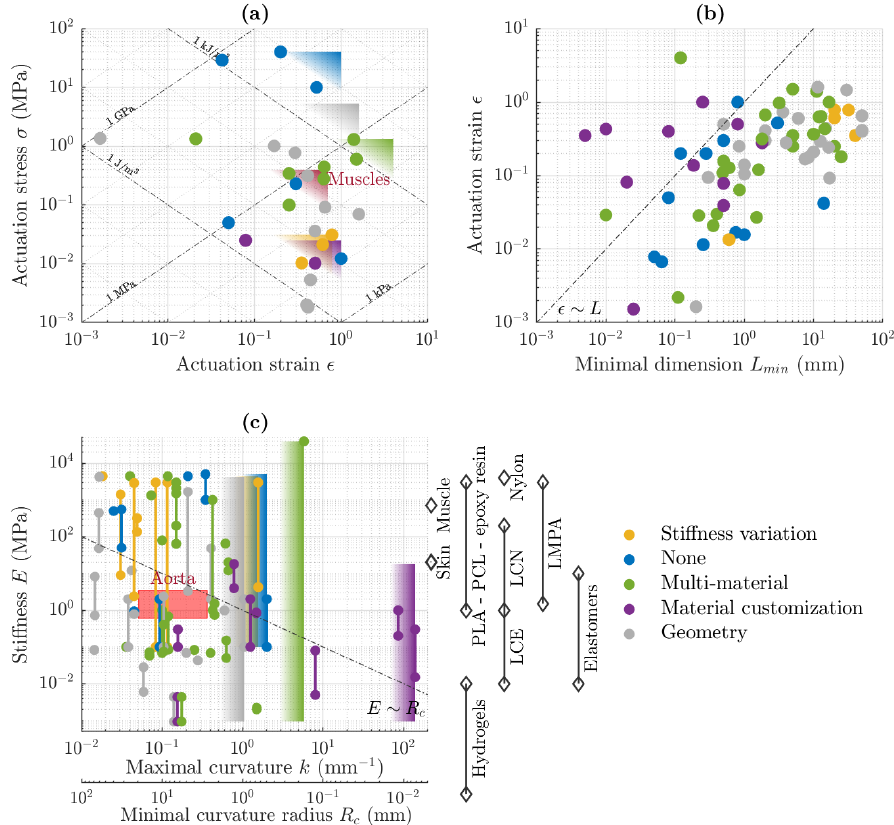
Figure 9. Comparison of the different types of extrinsic asymmetries: each dot or line represents one actuator, and each color is a type of asymmetry. The triangles or zones vertical and horizontal borders represent the maximal or minimal values reported for a given transducer. ( a ) Actuation stress as a function of the actuation strain. The diagonal lines of positive slope represent a constant value of σ / (cid:101) , which is a characterization of the stiffness of the actuator. The diagonal lines of negative slope σ(cid:101) are lines of constant energy density. ( b ) Actuation strain as a function of the minimal dimension. The dashed line has a slope of 1 ( (cid:101) ∼ L ). ( c ) Stiffness as a function of the curvature. The stiffness corresponds to the stiffness of the main actuator material. The right side of the zones represents the maximal curvature reported for a class of actuator, while their height corresponds to the range of stiffness reported. Typical materials stiffness are reported on the right side of the graph. The dashed line has a slope of − 1 ( E ∼ R c ∼ 1/ k ). See Figure A1 for